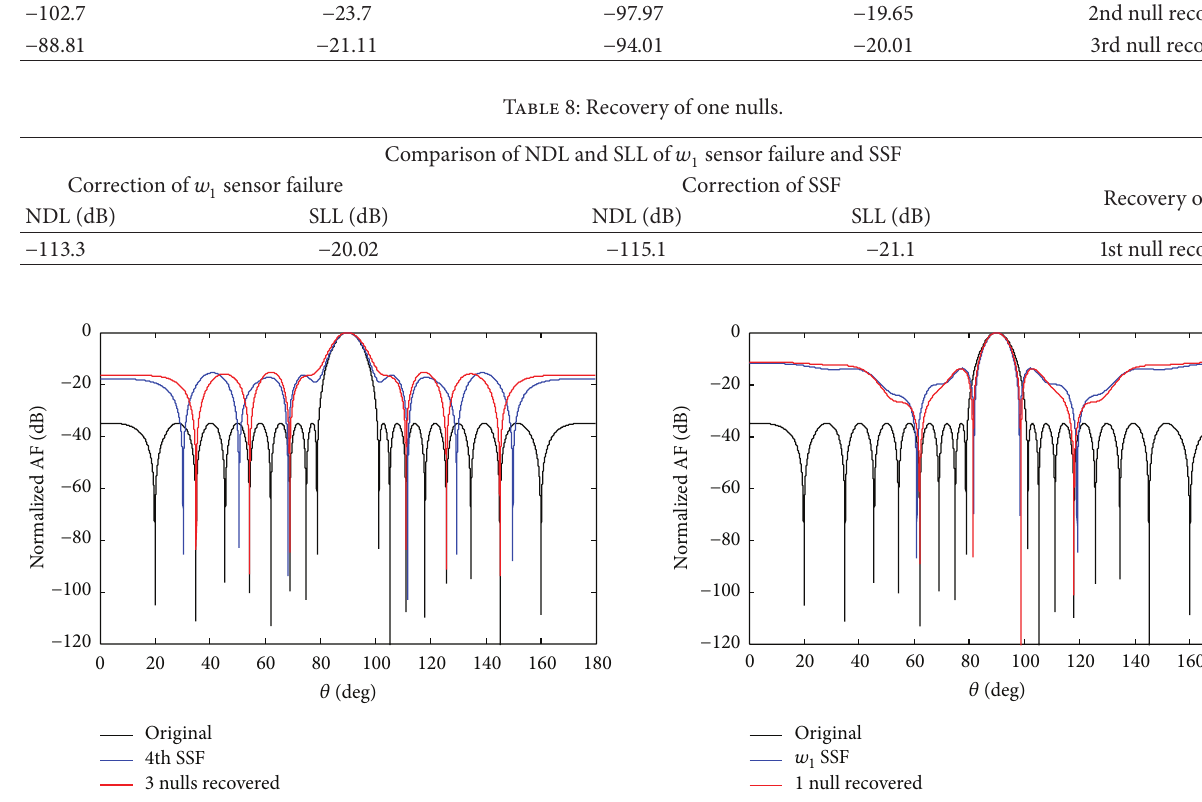
Figure 15: The original radiation pattern, the 𝑤 1 SSF, and recovery of one null.